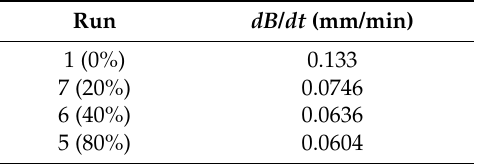
Table 4. Average channel bank widening rate of unilateral vegetation cover.